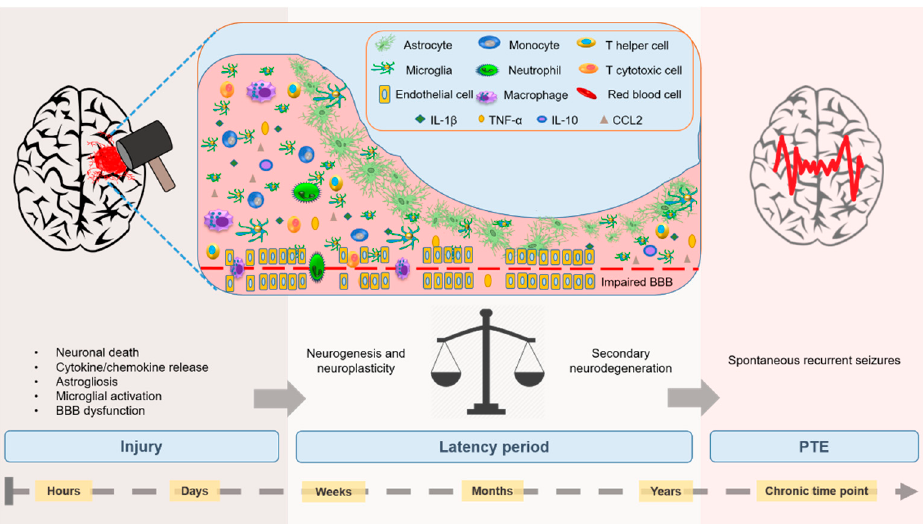
Figure 1. Temporal development of post-traumatic epilepsy (PTE). Traumatic brain injury (TBI) initiates a cascade of pathological processes including neuronal death and neuroinflammation, characterized by cytokine and chemokine upregulation (IL-1 β , TNF α , IL-10 and CCL2), BBB dysfunction (endothelial cell disruption and red blood cell infiltration), activation of astrocytes and microglia, and infiltration of blood-derived leukocytes into the brain, including monocytes, macrophages, neutrophils and T-cells (please refer to Section 2 for further details on these factors). These processes may also influence chronic outcomes such as the development of PTE, which occurs across three phases. The first phase is the initial insult and the associated molecular and cellular mechanisms within the subsequent minutes to days. Next is a latency period (days to years after the primary injury). During this time, injury-induced neurogenesis and neuroplasticity contribute to repair and regrowth, while simultaneously, ongoing secondary injury processes promote neurodegeneration. Neuroinflammation is a key player in this response, and is thought to facilitate hyperexcitability in the brain which may ultimately result in spontaneous, recurrent seizures characteristic of PTE.